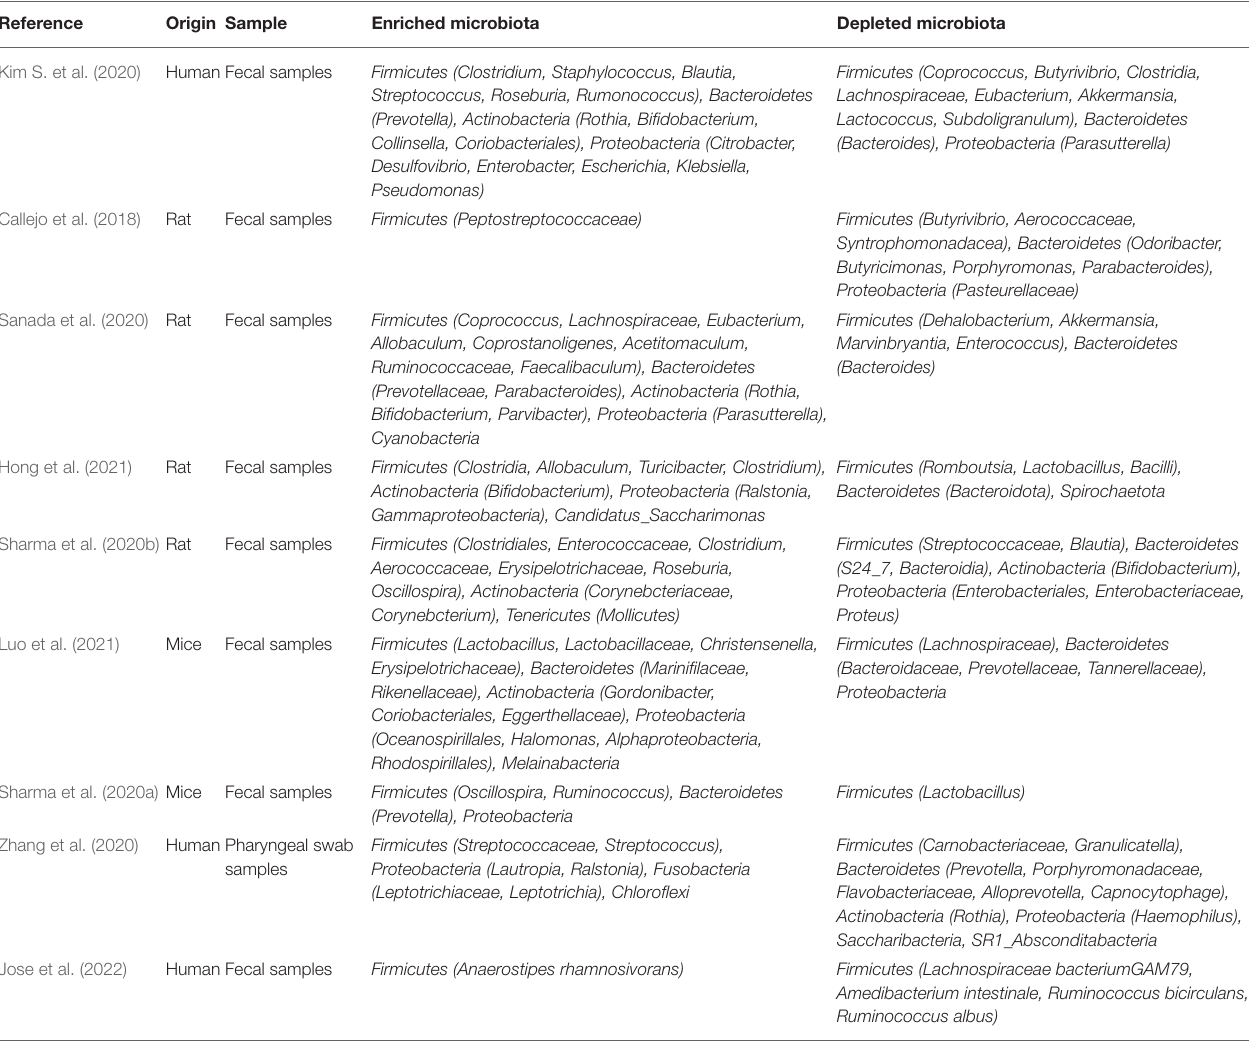
TABLE 1 | Alterations of Microbiota in